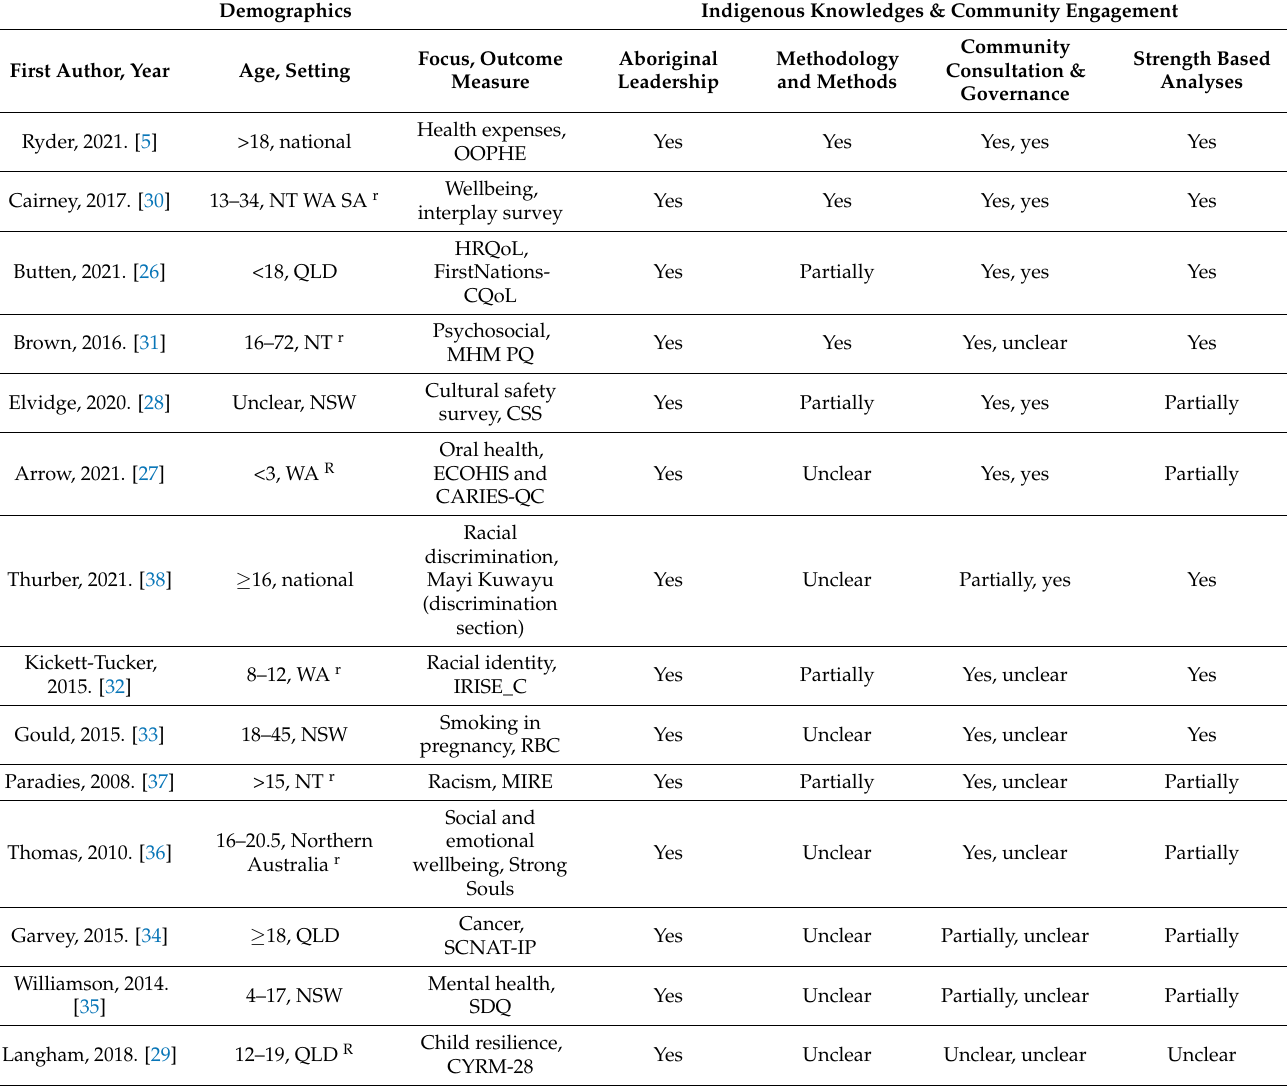
Table 3. Data items from charting the data (demographics and community). Note: data were sorted according to Indigenous knowledge and community engagement